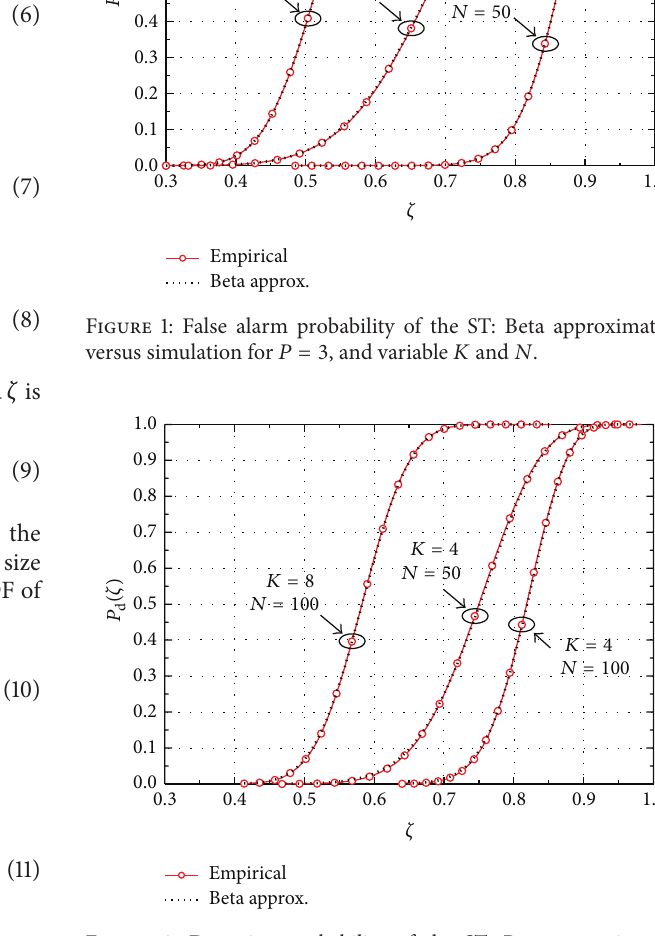
Figure 2: Detection probability of the ST: Beta approximation versus simulation, for variable 𝐾 and 𝑁 , 𝑃 = 3, SNR 1 = − 1dB, SNR 2 = − 3dB, and SNR 3 = − 10